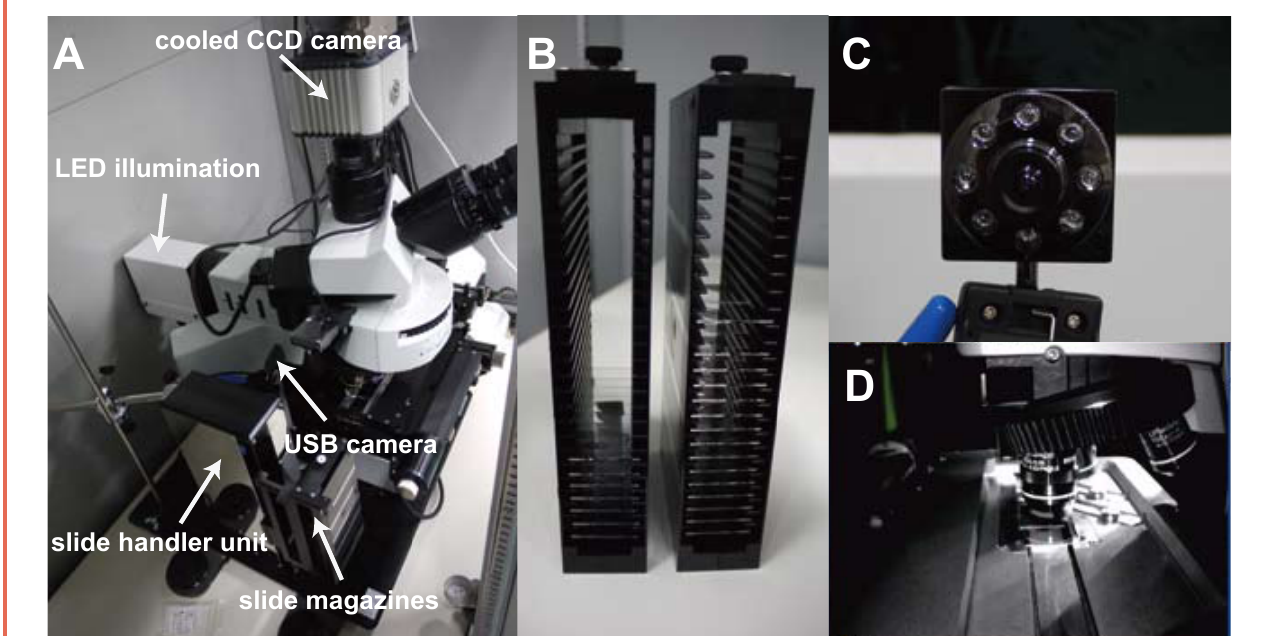
Figure 3. Newly constructed automatic microscopic system with slide handler. [A] Overview of the system. All the units are operated in a dark and cool (15°C) chamber. [B] Slide magazines capable of carrying 25 slides each. [C] USB-connected monitoring camera with infrared LED. [D] The system is monitored without opening the door of the